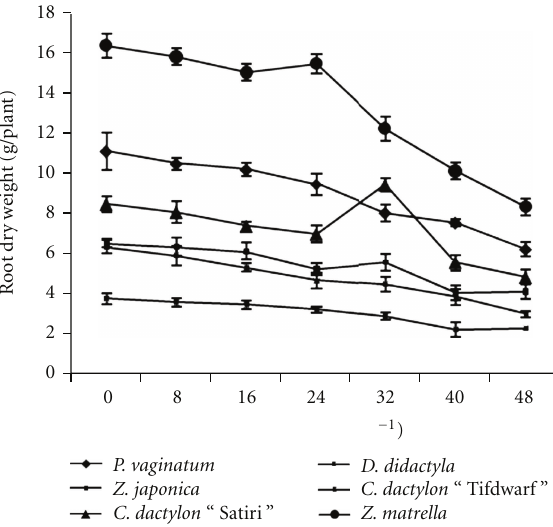
ff erent salinity levels of six turfgrass